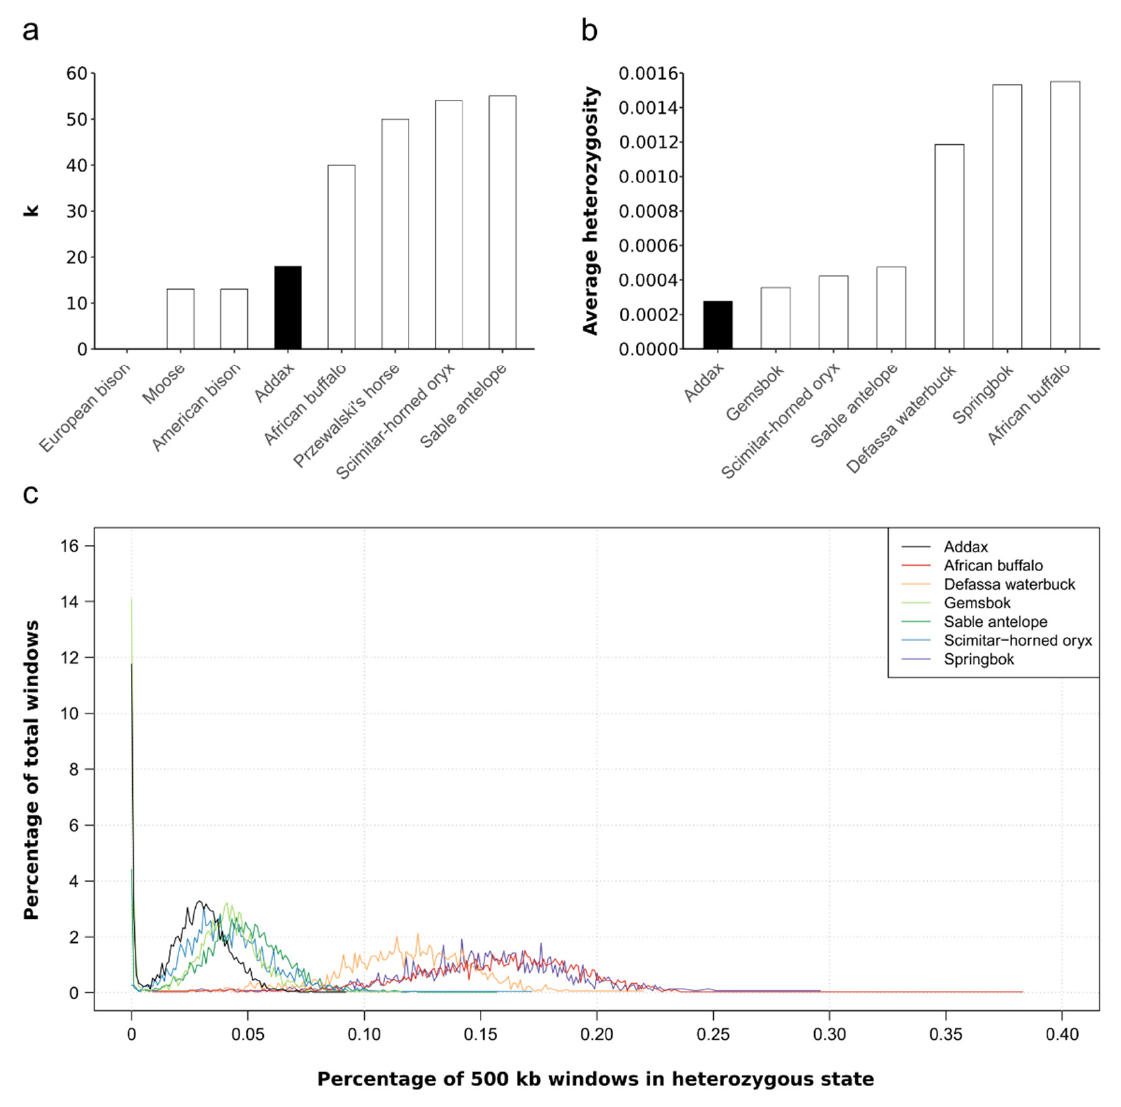
Figure 2. Comparisons of mitochondrial and nuclear diversity . ( a ) Comparison of the overall average pairwise distance of the addax ( Addax nasomaculatus ) with seven wild ungulate species using seven complete mitochondrial genome sequences per species. k gives the average number of substitutions between two individuals of the same species. Note that the value for the European bison is zero. ( b ) Comparison of the average autosomal heterozygosity of the addax with six wild ungulate species. ( c ) Heterozygosity for 500-kb sliding windows across the autosomal scaffolds of seven wild ungulates species. The addax is marked in black in all